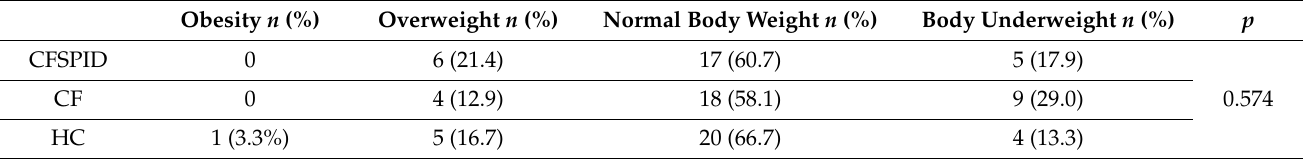
Table 1. Nutritional status of the study